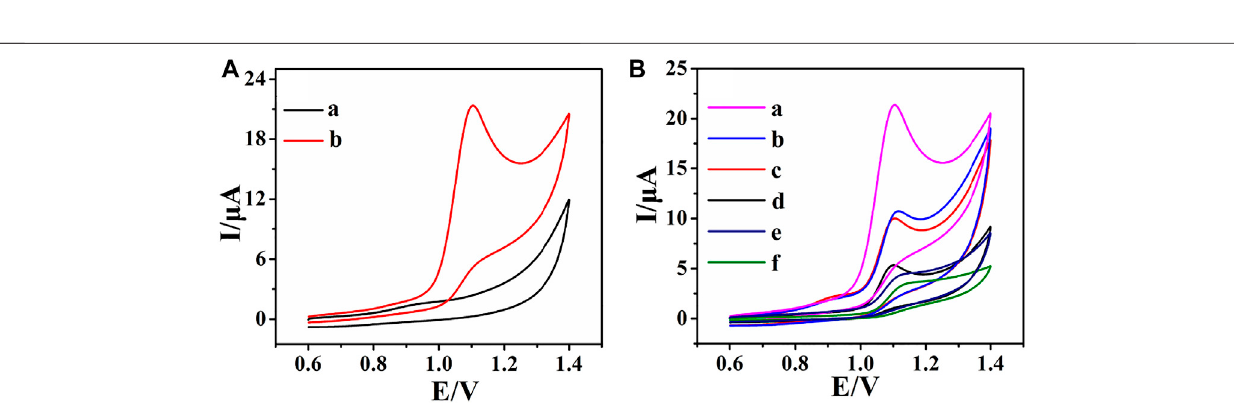
Frontiers in Chemistry |